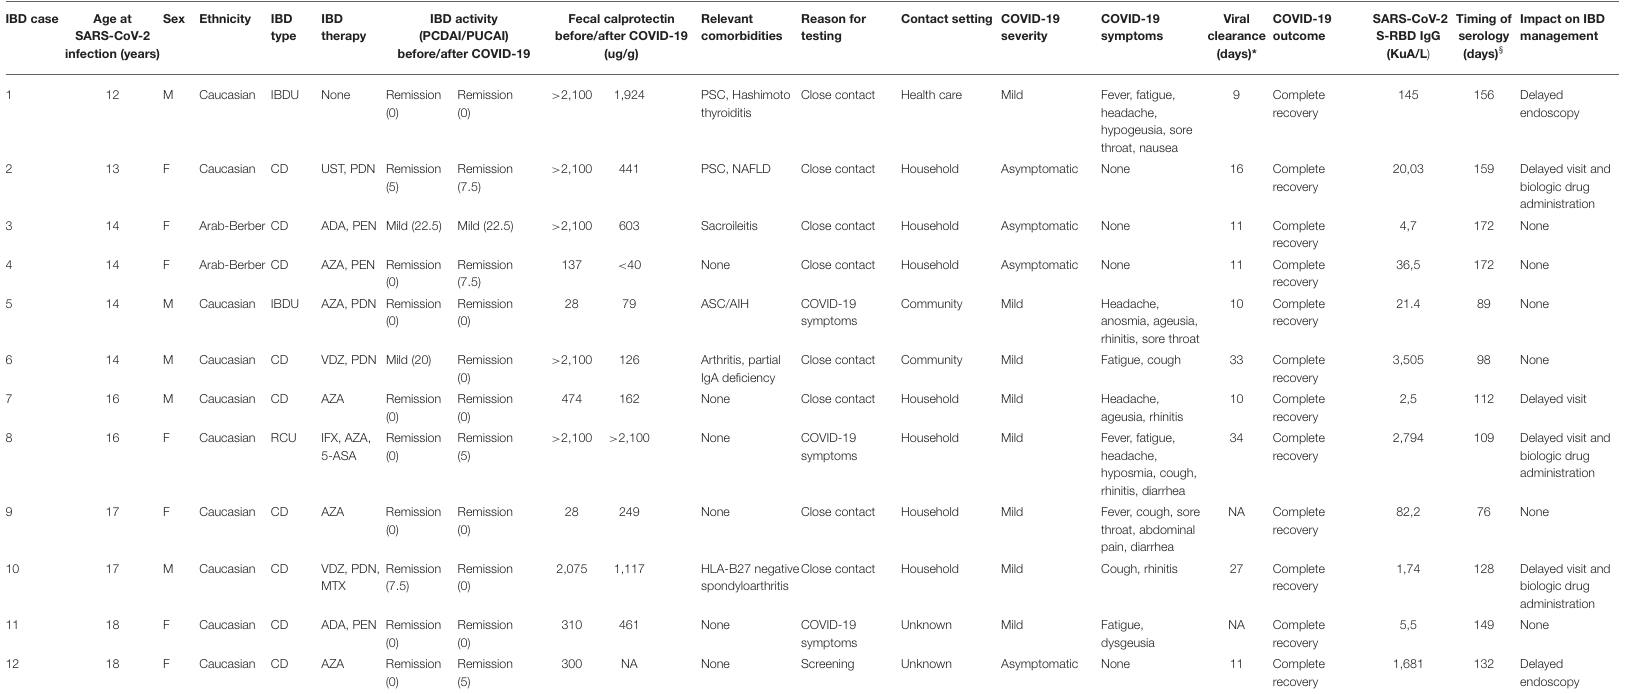
TABLE 1 | Demographics and clinical characteristics of SARS-CoV-2 cases within our pediatric IBD cohort. IBDcase Ageat infection(years)Sex Ethnicity IBD IBD type SARS-CoV-2